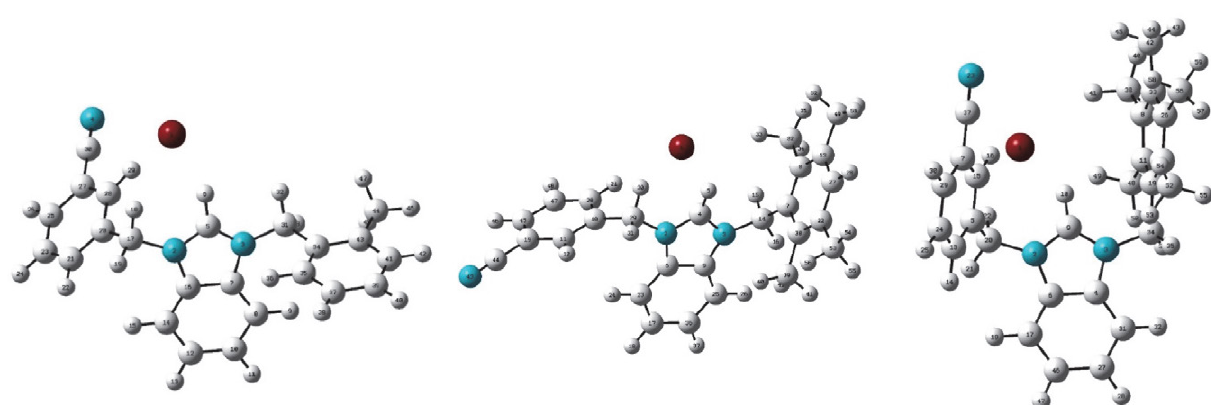
Fig. 4. Optimized geometries of the compounds 2b , 2f and 2g ,